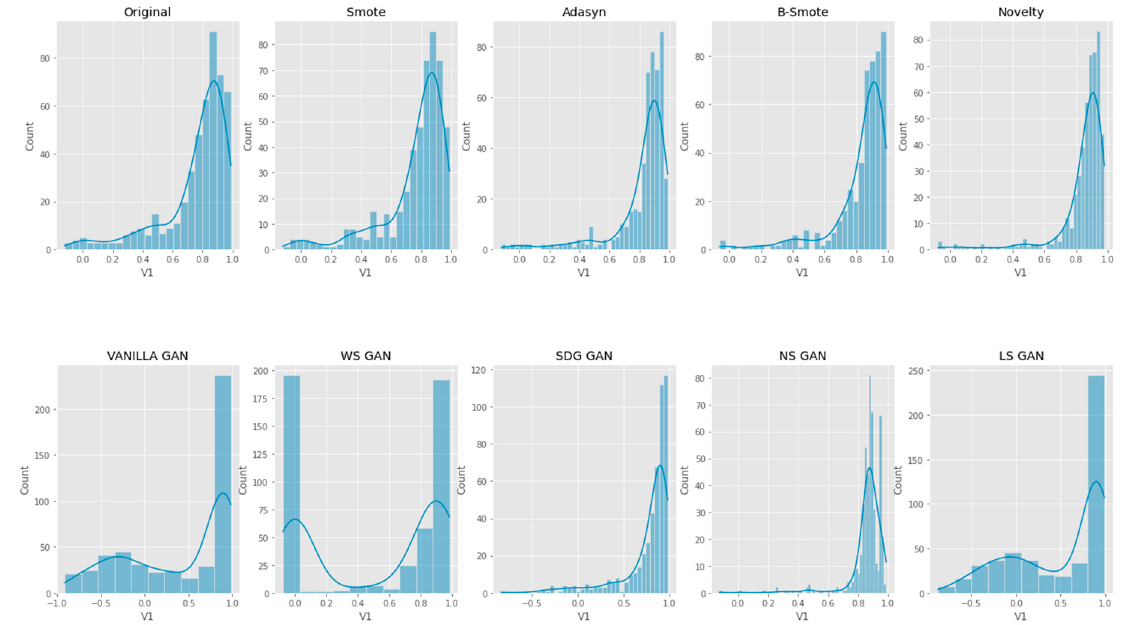
Figure 14. Univariate V1 Feature Distribution comparison of Original Data, Smote, ADASYN, B-